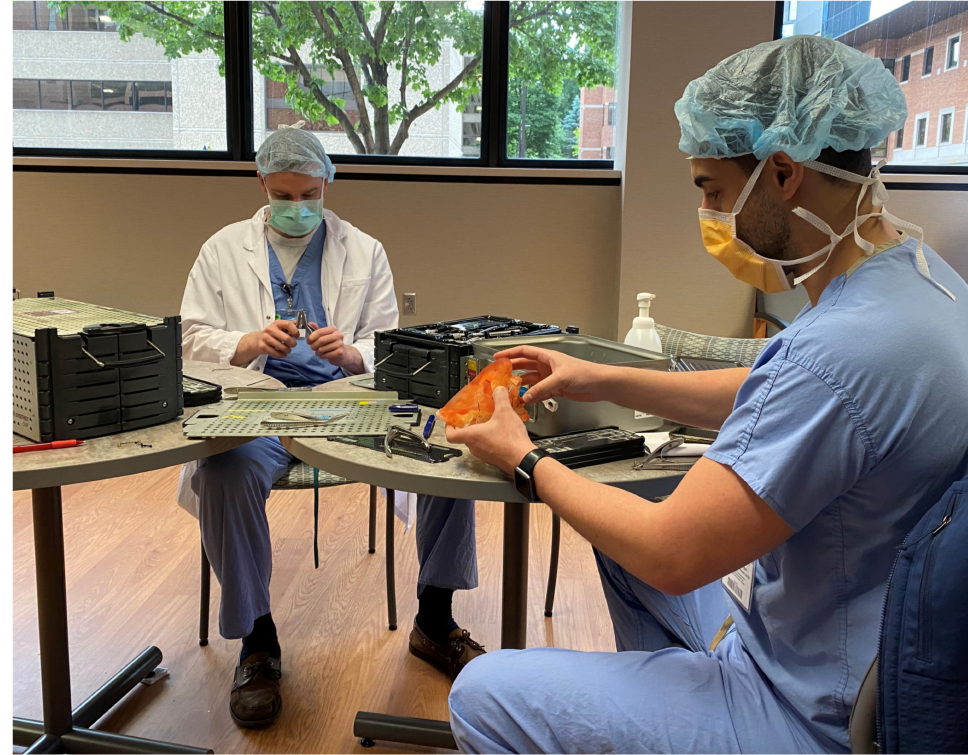
Figure 3. Using the high fidelity 3DP model preoperatively to teach trainees how to bend plates and review pertinent anatomy and surgical